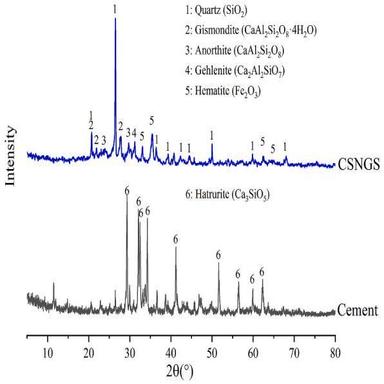
XRD patterns of cement and CSNGS.